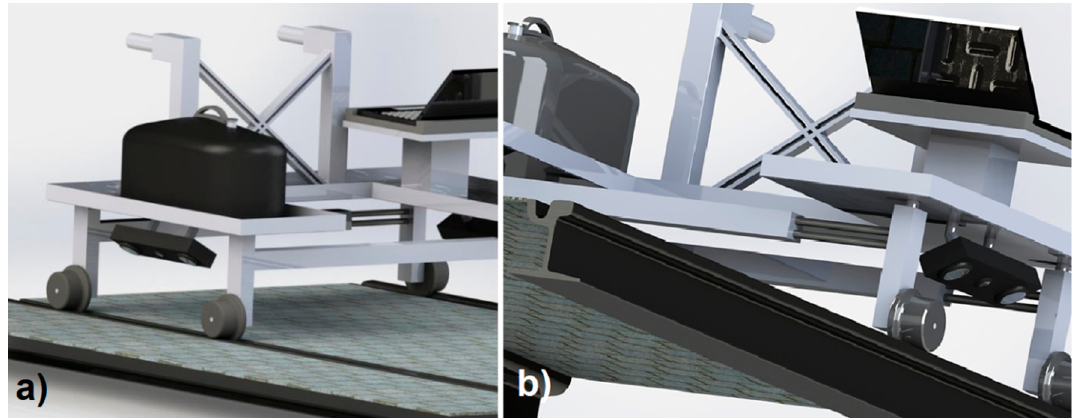
Figure 9. 3D scanners on the trolley: ( a ) right side; ( b ) left side.